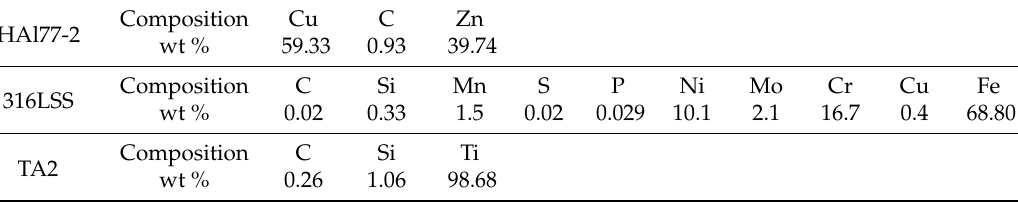
Table 1. Composition of aluminum–brass (HAl77-2), 316L stainless steel (316L SS), and titanium